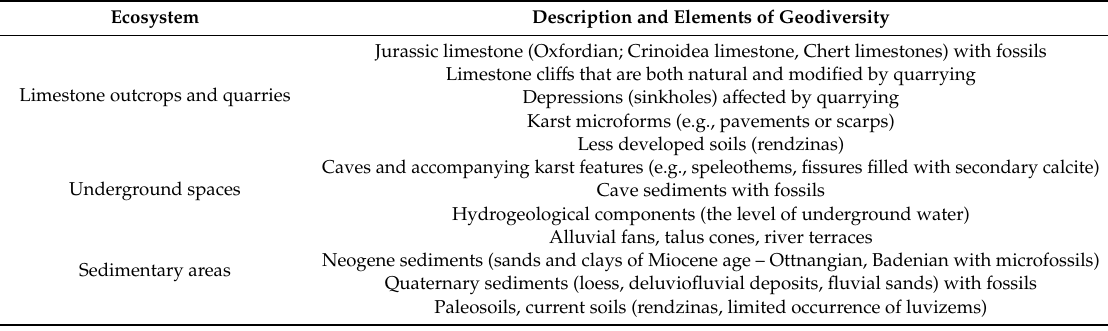
Table 4. Characteristics and elements of geodiversity associated with ecosystems.